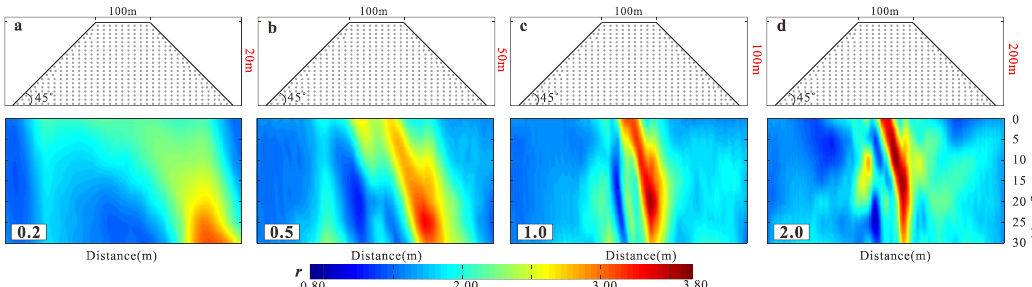
Figure 18. Variations of the seismic responses along the slope ridges and the slope crests of the real amplification ratio ( r ) of PGA with varied angles of wave incidence at different slope heights. ( a ) slope height of 20 m, ( b ) slope height of 50 m, ( c ) slope height of 100 m, ( d ) slope height of 200 m